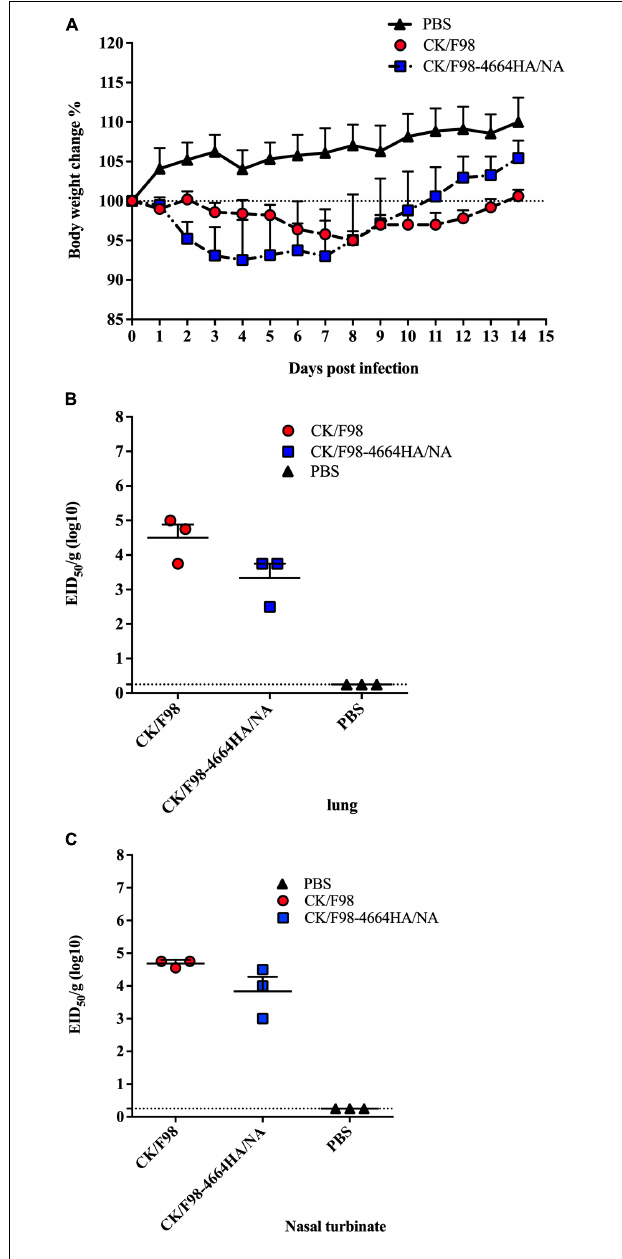
FIGURE 3 | H7N9 surface genes were not sufficient to convert low pathogenicity and replication of H9N2 virus in mouse. Mice were intranasally inoculated with a single dose of 10 6 EID50 of either the parental H9N2 CK/F98 virus or the CK/F98-4664HA/NA hybrid virus with both HA and NA genes derived from H7N9 SH/4664 virus. (A) Weight loss during a 14-day observation period. (B) Virus titers in animal lungs, as determined by EID50 using MDCK cells. (C) Virus titers in animal nasal turbinates, as determined by EID50 using MDCK cells. n = 3 for each group. Data are expressed as mean ± SEM. Statistical significance was analyzed by one-way